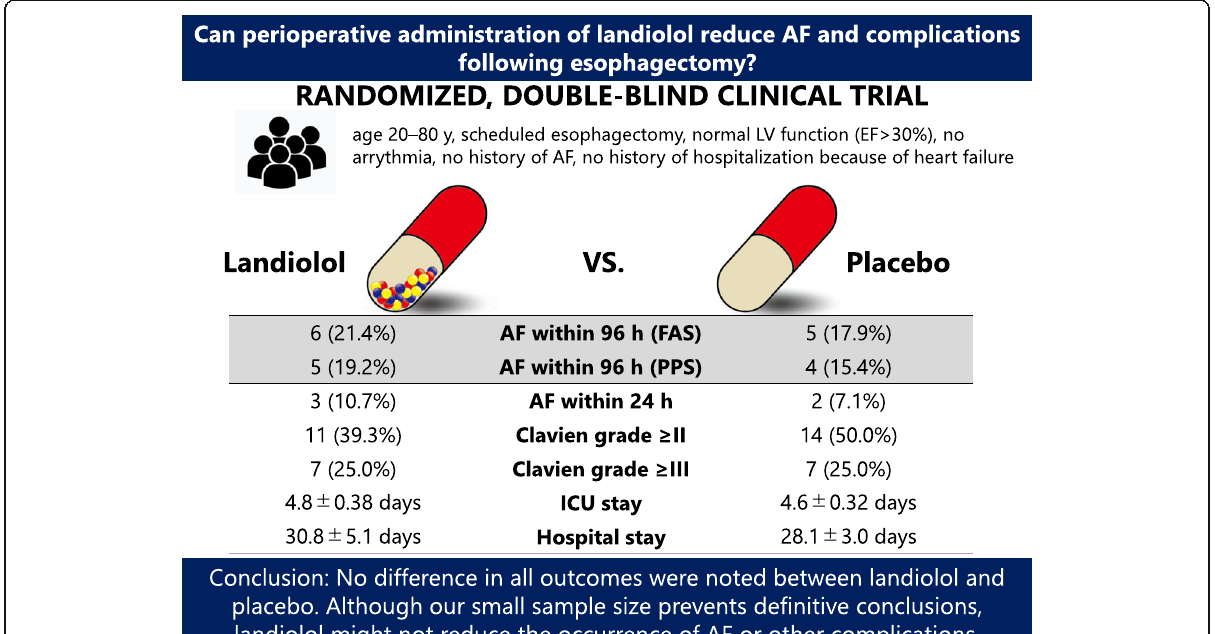
Fig. 2. Graphical abstract. AF, atrial fibrillation; LV, left ventricular; FAS, full analysis set; PPS, per-protocol, set; ICU, intensive care